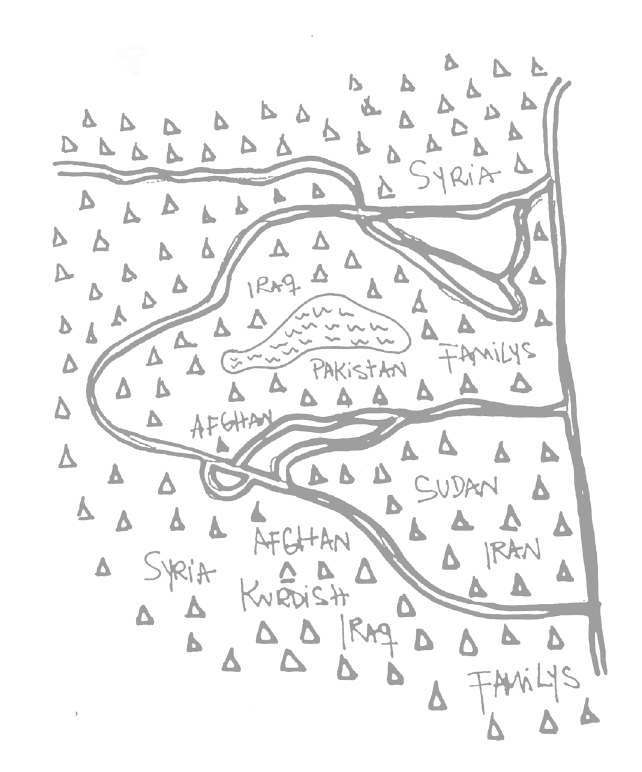
Figure 4 Melanye Garland, Field drawing, Copy of the